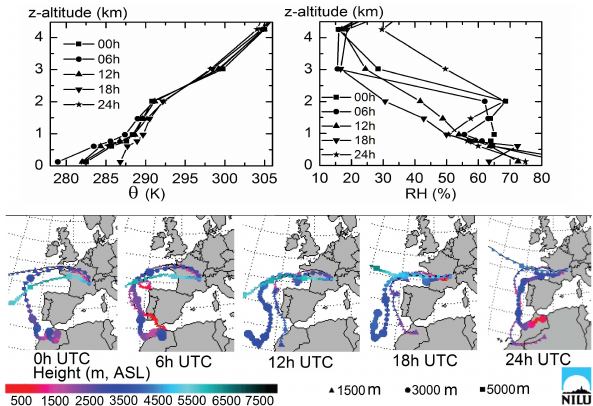
Fig. 8. Upper panel: relative humidity (RH) and potential tem- perature ( θ ) vertical profiles on 18 October 2011 at Lyon (M´et´eo France). Lower panel: FLEXTRA 7-day air mass back trajectories showing the history of air masses arriving in the Lyon atmosphere on 18 October